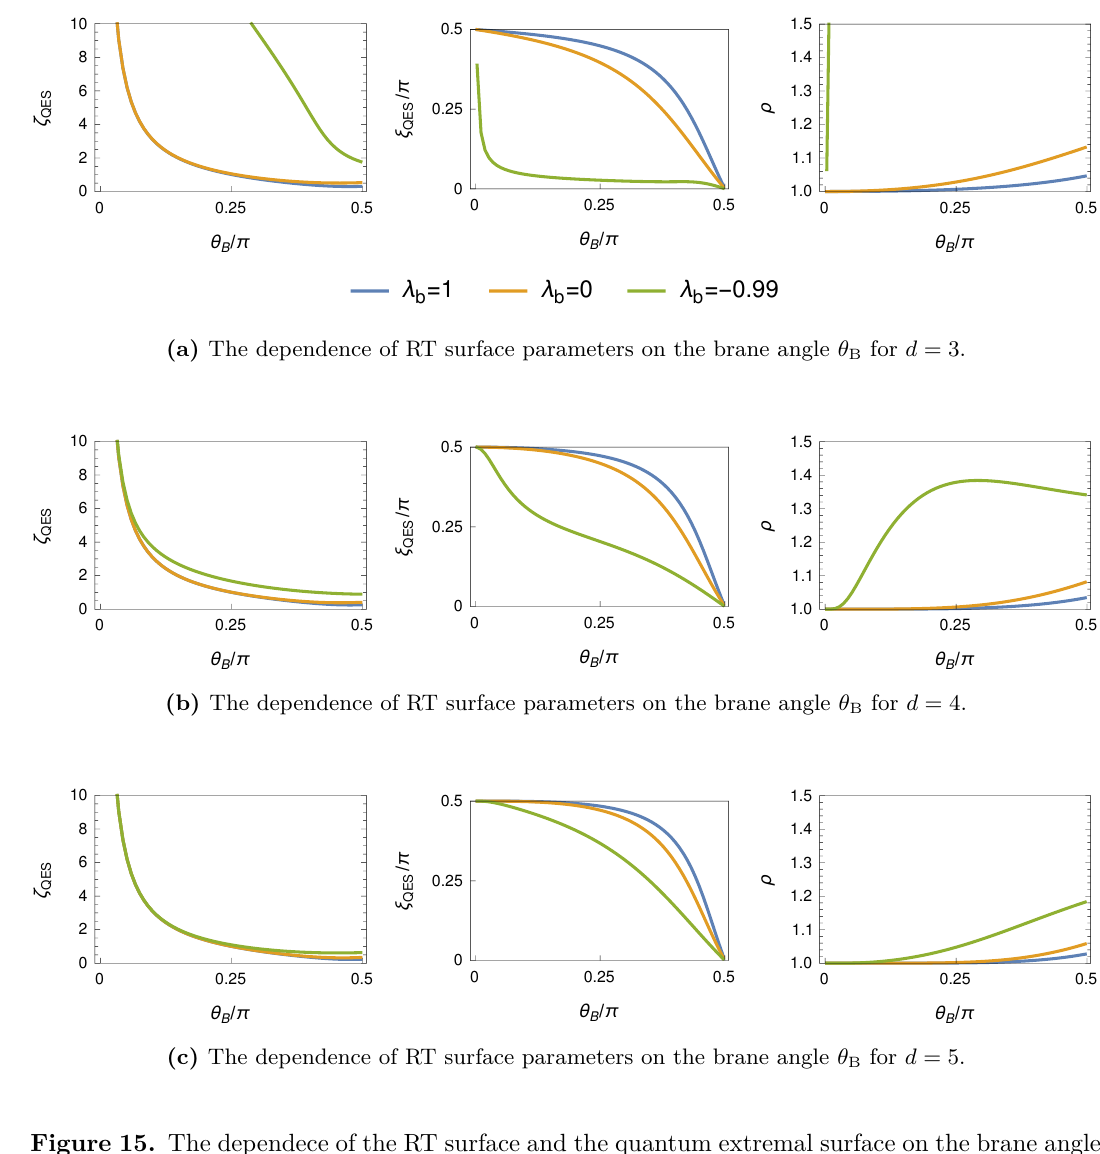
Figure 15. The dependece of the RT surface and the quantum extremal surface on the brane angle θ for d = 3 , 4 and 5 . The location of the entangling surface is chosen to be χ Σ = 1 B